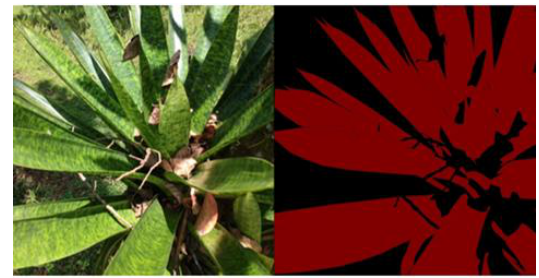
Figure 2. Aerial image (left) of W. kupperiana and the annotated image (right) with the mask (red) containing pixels of the target plant. Dried parts of the plants were not included in the